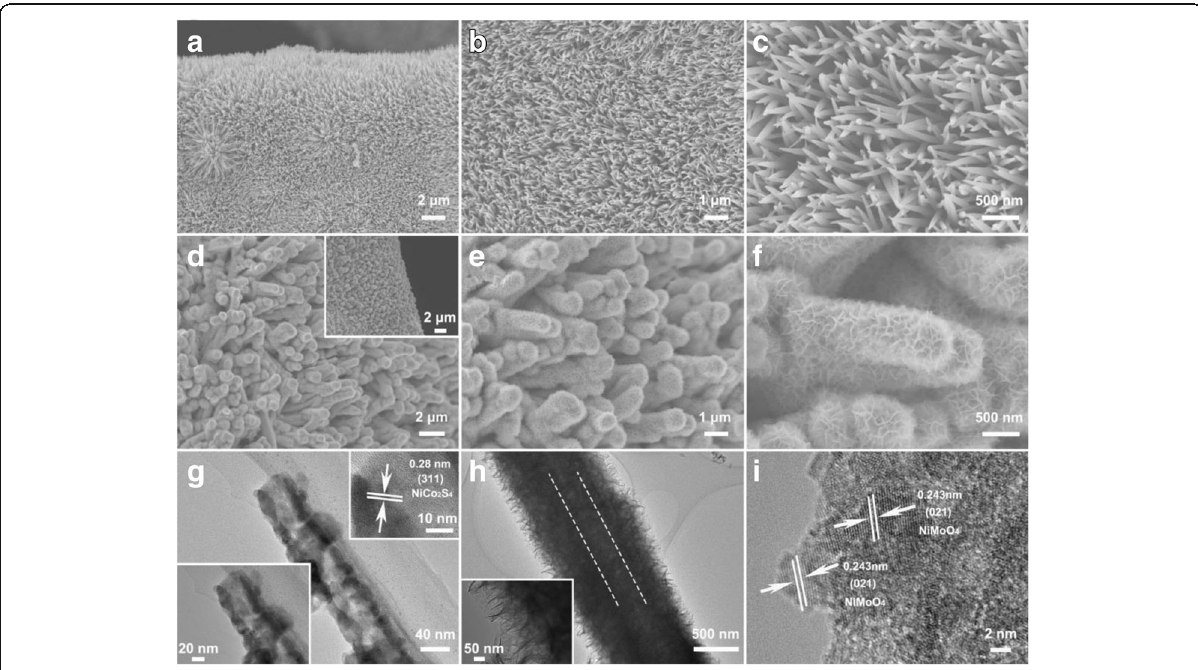
Fig. 3 SEM images for NiCo 2 S 4 /NF ( a – c ) and NiCo 2 S 4 @NiMoO 4 /NF ( d – f ) at different magnifications. g TEM images of an individual NiCo 2 S 4 nanotube detached from Ni foam; the above inset is the corresponding HRTEM image of a single nanotube. h TEM images and i HRTEM images of an individual NiCo 2 S 4 @NiMoO 4 core-shell